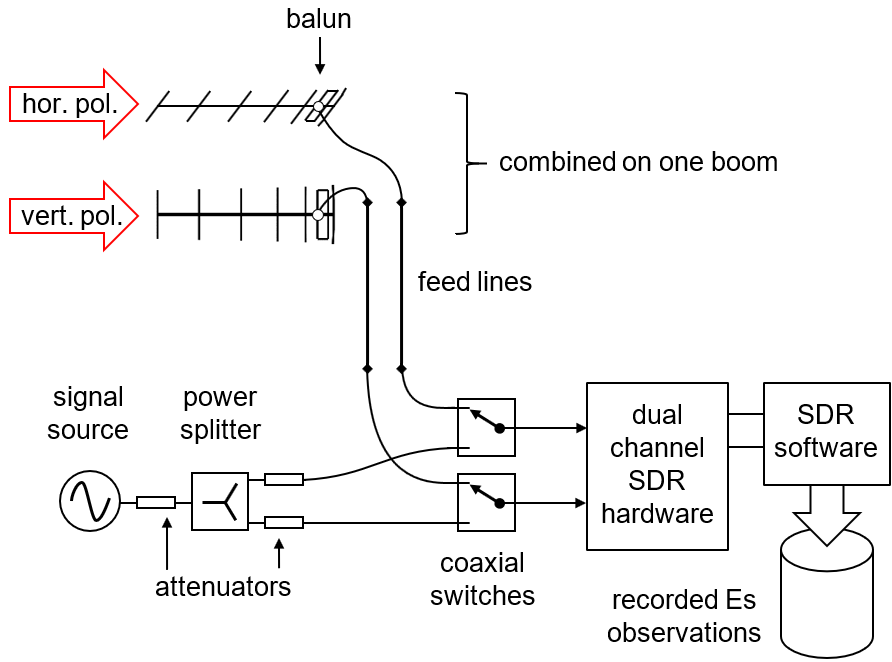
Figure 2. Measurement system block diagram. © 2021 IEEE. Reprinted, with permission, from [21].